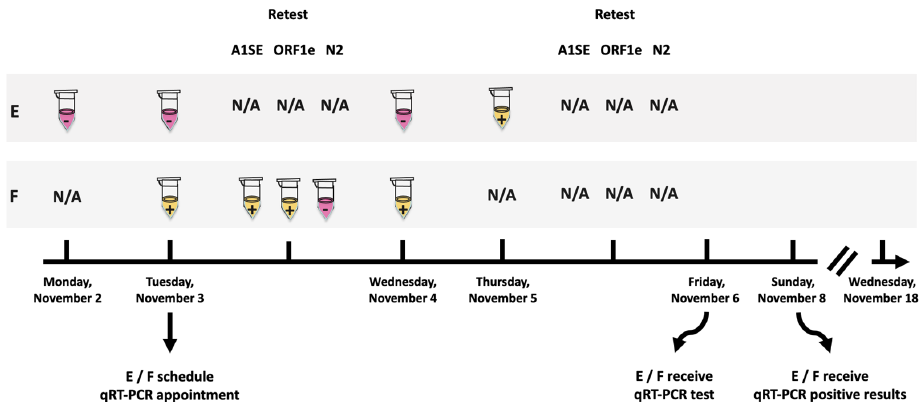
Figure 4. Timeline of E and F cases. Beginning on 2 November, individual E tested negative for SARS-CoV-2. Tuesday, 3 November, saliva samples for E and F were subjected to RT-LAMP using AS1E. Upon F testing positive, the sample retested positive with AS1E and ORF1e, but not for the N2 primer sets against SARS-CoV-2. E and F scheduled an appointment for qRT-PCR testing. On Wednesday, 4 November, E tested negative and F remained positive. On Thursday, 5 November, E’s saliva sample was positive for SARS-CoV-2 with the AS1E primer set and further testing was omitted. Friday, 6 November, and Sunday, 8 November: E and F received qRT-PCR tests and were confirmed positive, respectively. A positive test for SARS-CoV-2 is represented in yellow with a “+” and a negative test is denoted in pink with